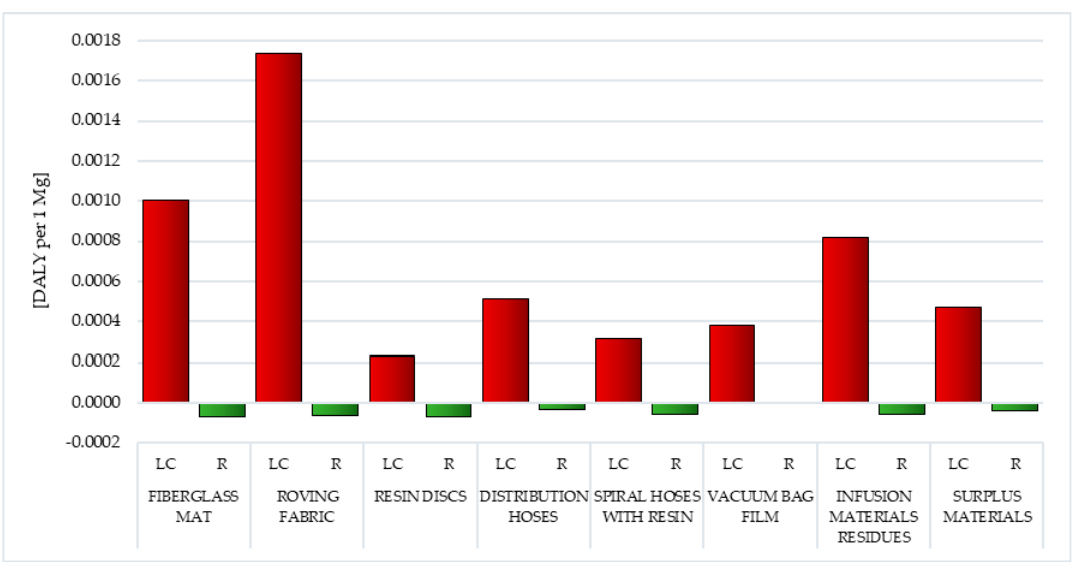
Figure 7. Characterization results of environmental consequences for compounds causing climate change present in selected postproduction waste of wind power plant blades: LC—life cycle, R—recycling [unit: DALY per 1 mg].